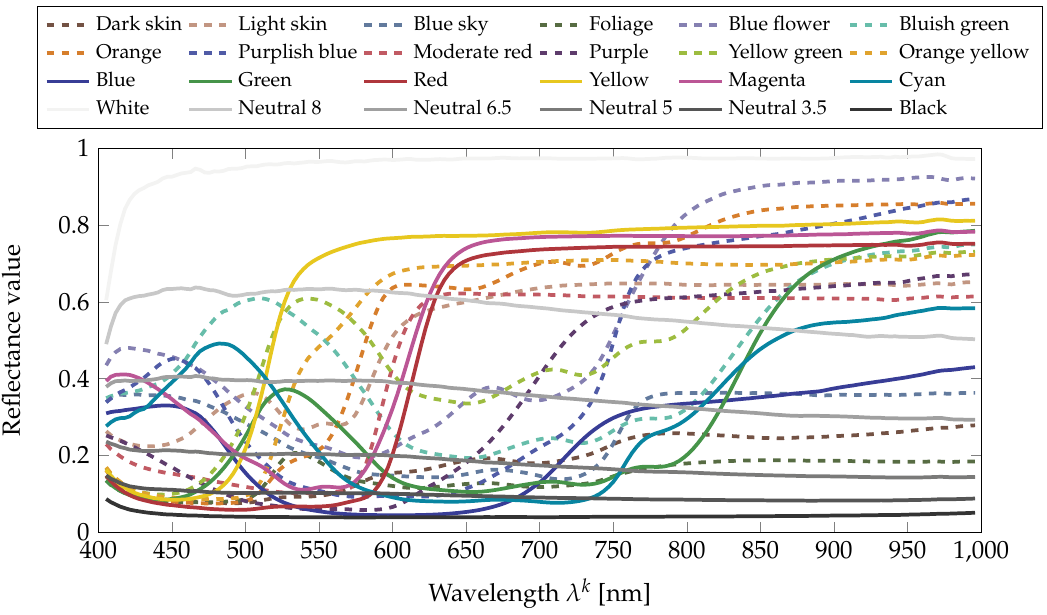
Figure 6. Spectral reflectances of the 24 patches of a Macbeth ColorChecker computed from the data acquired by the HySpex VNIR-1800 (on average on 200 × 200 pixels for each patch). The color of a curve is the sRGB color of the corresponding patch in the